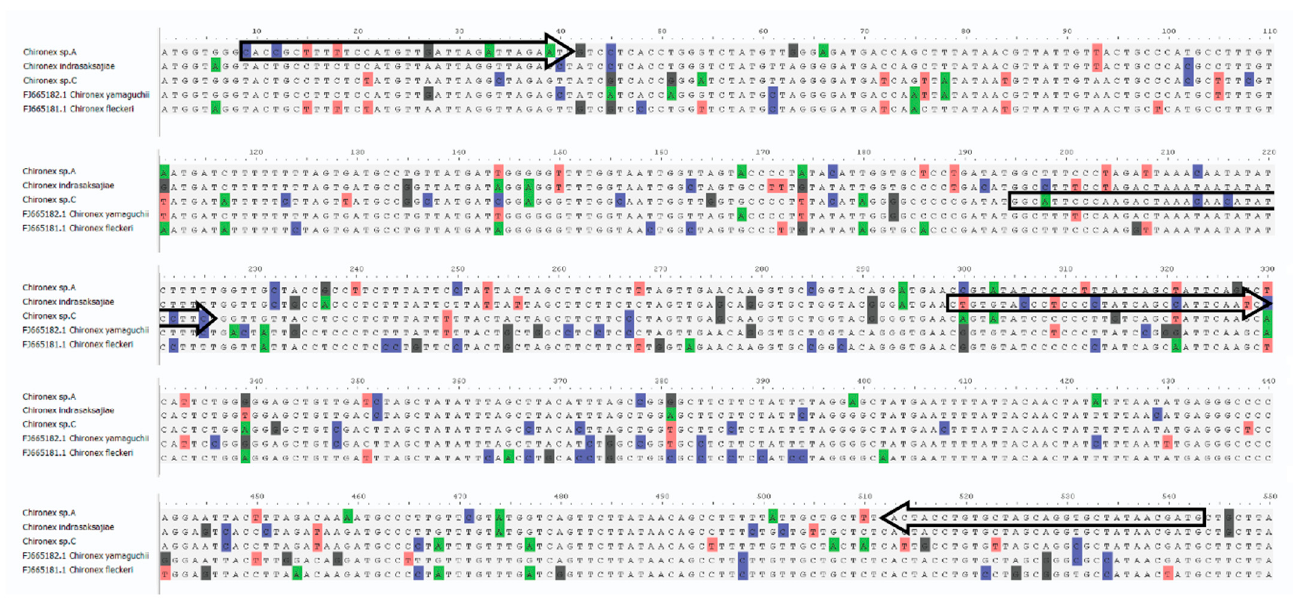
Figure 5. COI sequence alignment from five Chironex species. The forward arrows are forward primers; the reverse arrows are reverse primers. Table 3. List of the 16S rRNA primers of three Thai Chironex species.